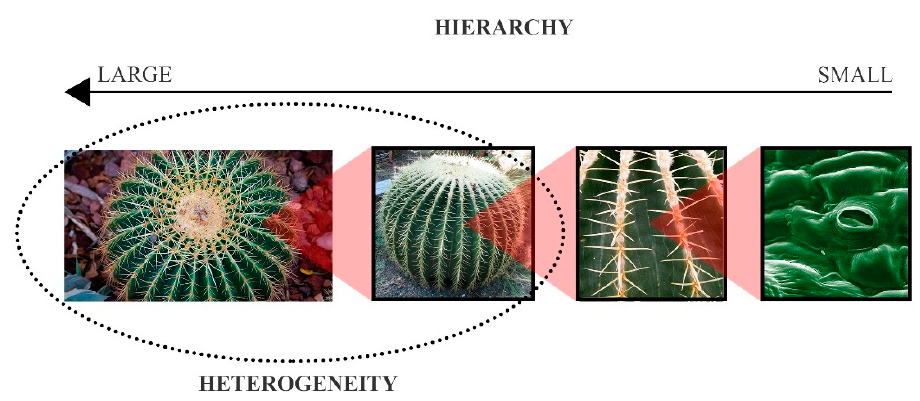
Figure 13. Multifunctionality through hierarchy and heterogeneity in Echinocactus grusonii.